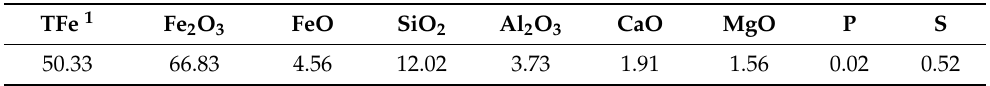
Figure 2. Macroscopic morphology of specularite. Table 1. Chemical composition of specularite (wt %).